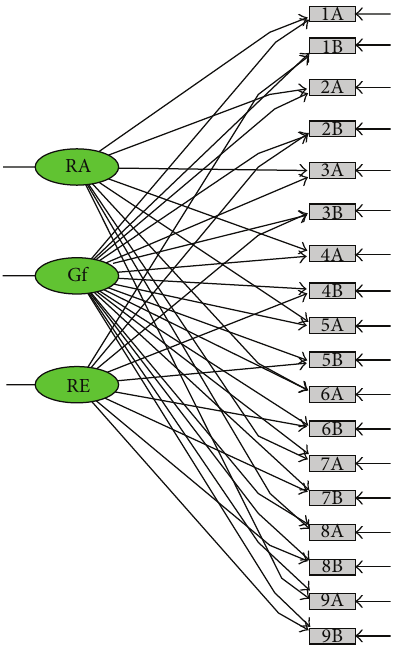
Figure 3: Bifactor model.